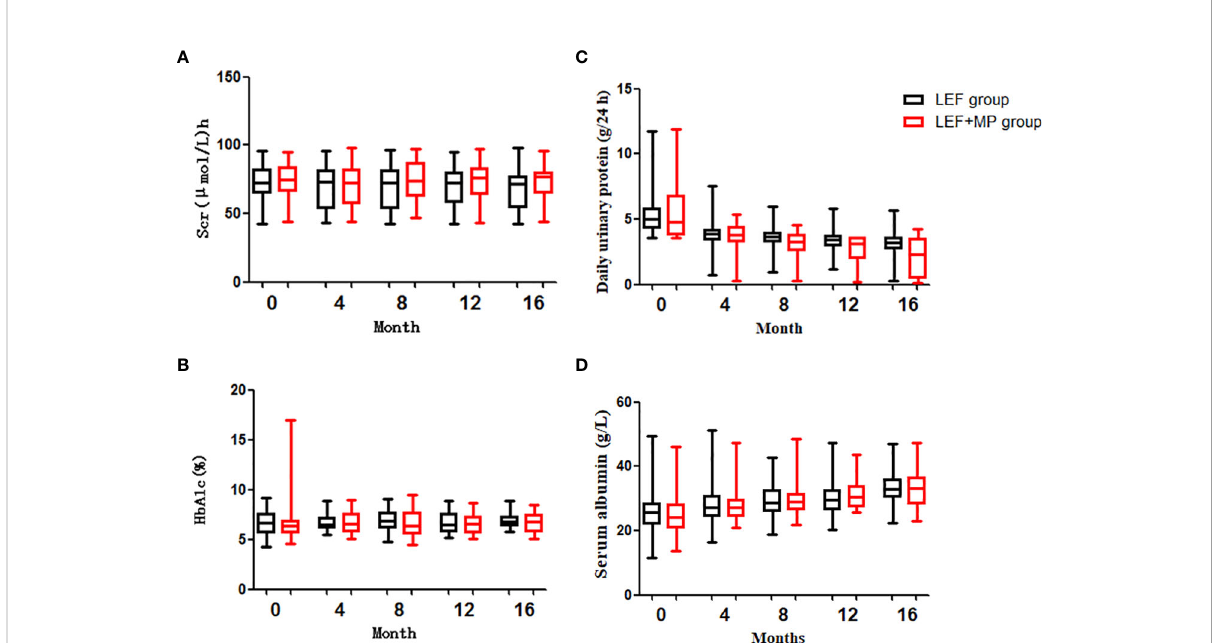
FIGURE 4 Clinical indicators (SCr, HbA1c, daily urine protein, serum albumin). (C) shows that the decrease in proteinuria was signi fi cantly greater in the TAC+TMG group than in the LEF group at months 12 th and 16 th ; (A, B, D) show that there were no signi fi cant differences in SCr, HbA1c, daily urine protein, or serum albumin levels in the LEF group and the LEF+MP group ( P